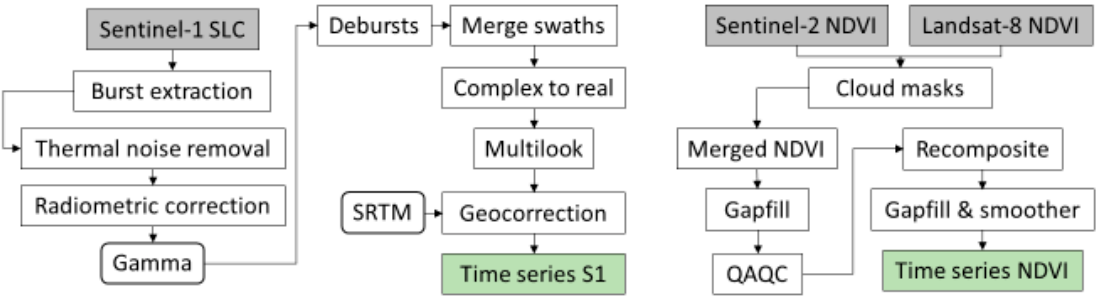
Figure 2. Workflow of automated preprocessing routines for moderate-resolution radar and optical imagery into intermediate products and Analysis Ready Data for classifying field crop conditions. NDVI: Normalized difference vegetation index; QAQC: Quality assessment quality control; SLC: Single look complex; SRTM: Shuttle radar topographic model.